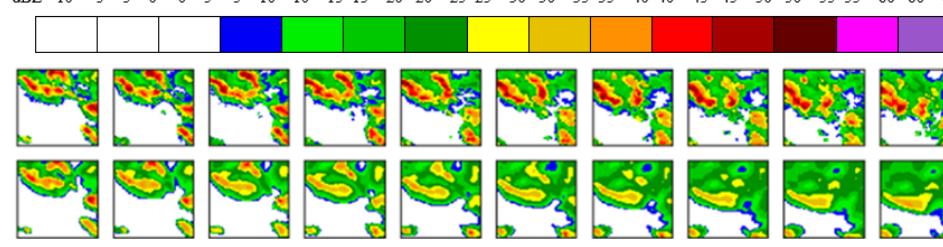
Figure 1. An instance of radar echo map prediction. The first line denotes the ground truth and the second line is the prediction by the ConvLSTM model. (Best view in